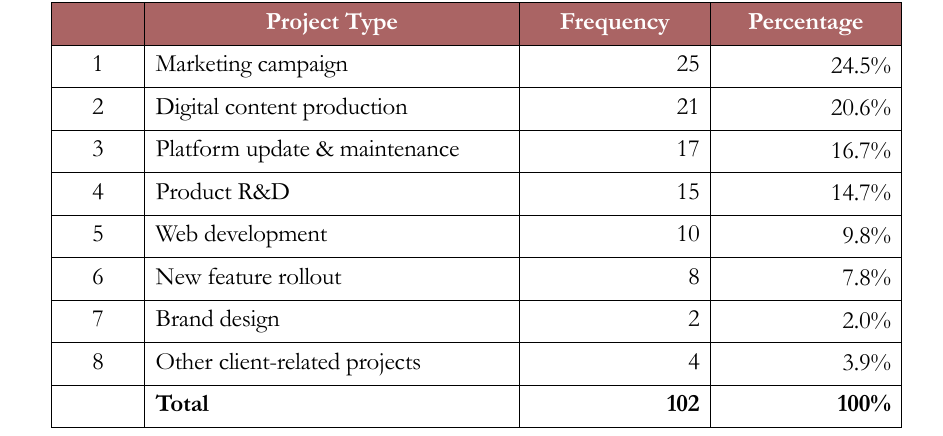
Table 4. Types of